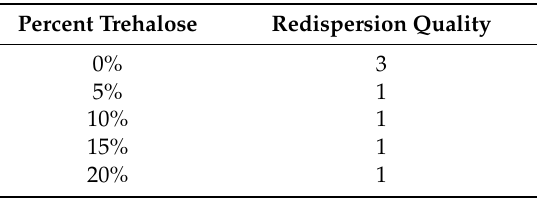
Table 7. E ff ect of trehalose concentration of the redispersibility of SLNs after lyophilization. Redispersion qualitative scale: 1—fully redispersed within 30 s of vortexing; 2—a few remaining undispersed visible agglomerates still present after 30 s of vortexing; 3—very little or no redispersion of solid after 30 s of vortexing.